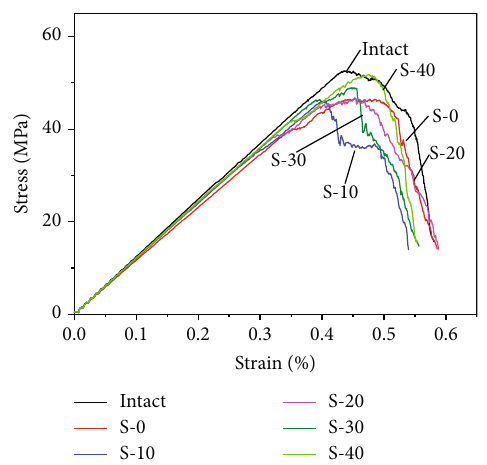
Figure 6: Stress-strain curves of models with di ff erent spacing between joints and tunnel.